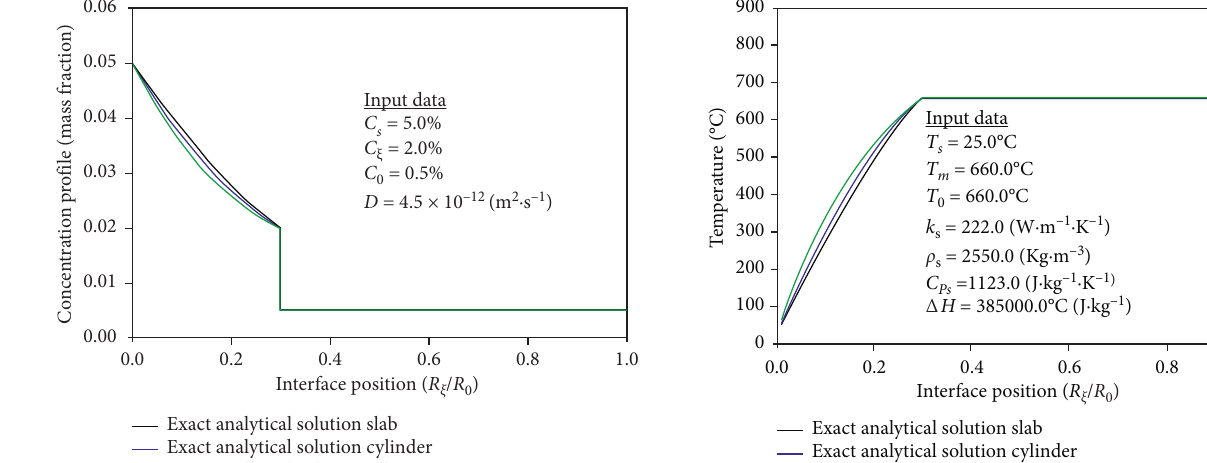
) at 30% of R / R . ξ 0 0